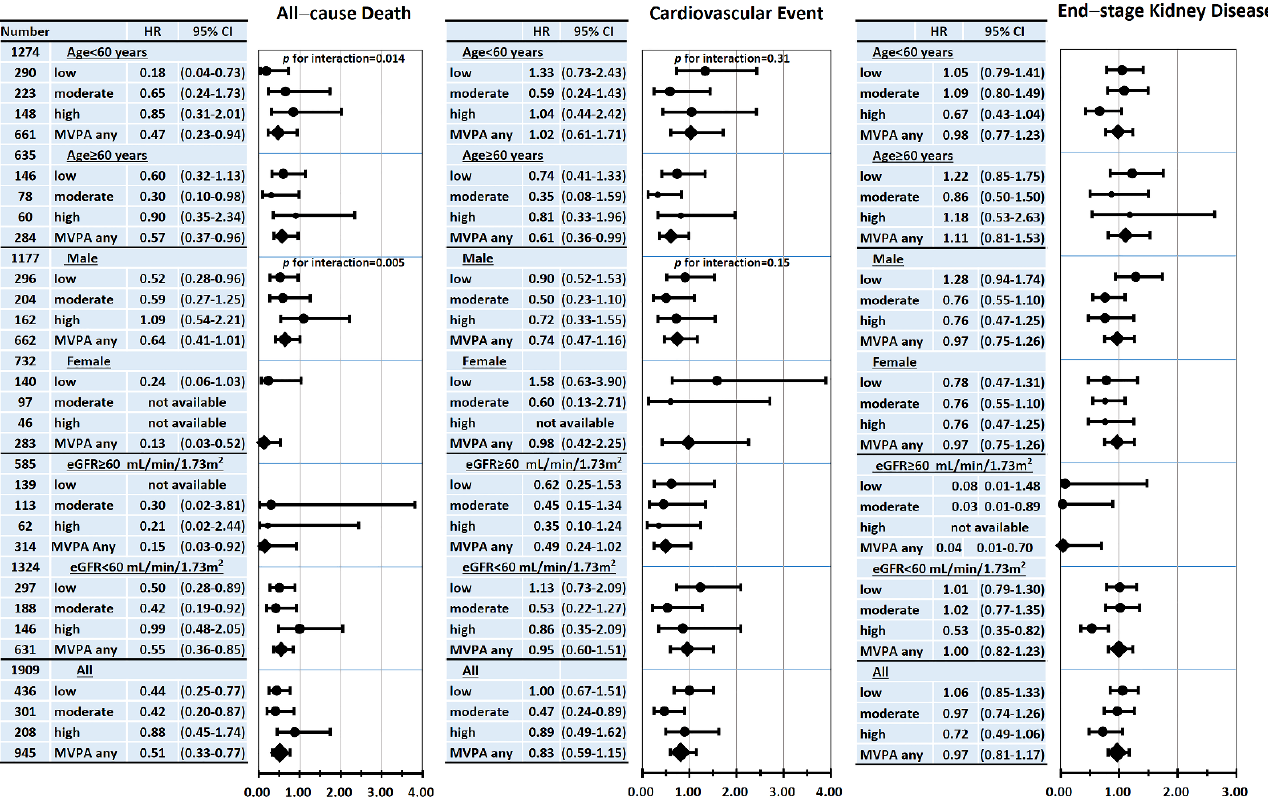
Figure 4. There were different risks of all-cause death and CVE across categories of MVPA amount according to subgroups in the multivariable-adjusted Cox proportional hazards model (Model 2).